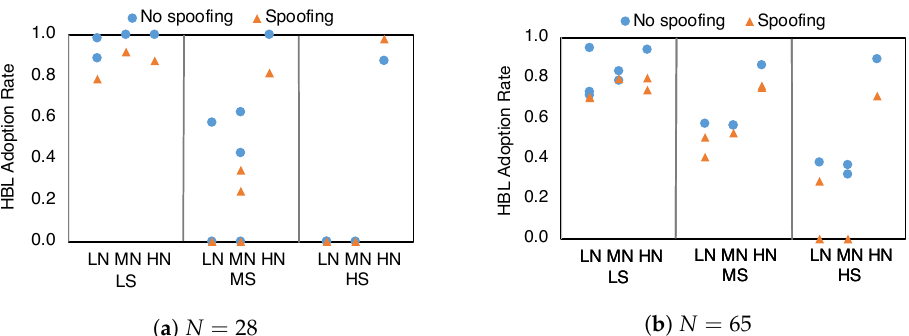
Figure 3. HBL adoption rates at equilibria in games with and without spoofing. Each blue (orange) marker specifies the HBL proportion at one equilibrium found in a specific game environment without (with)